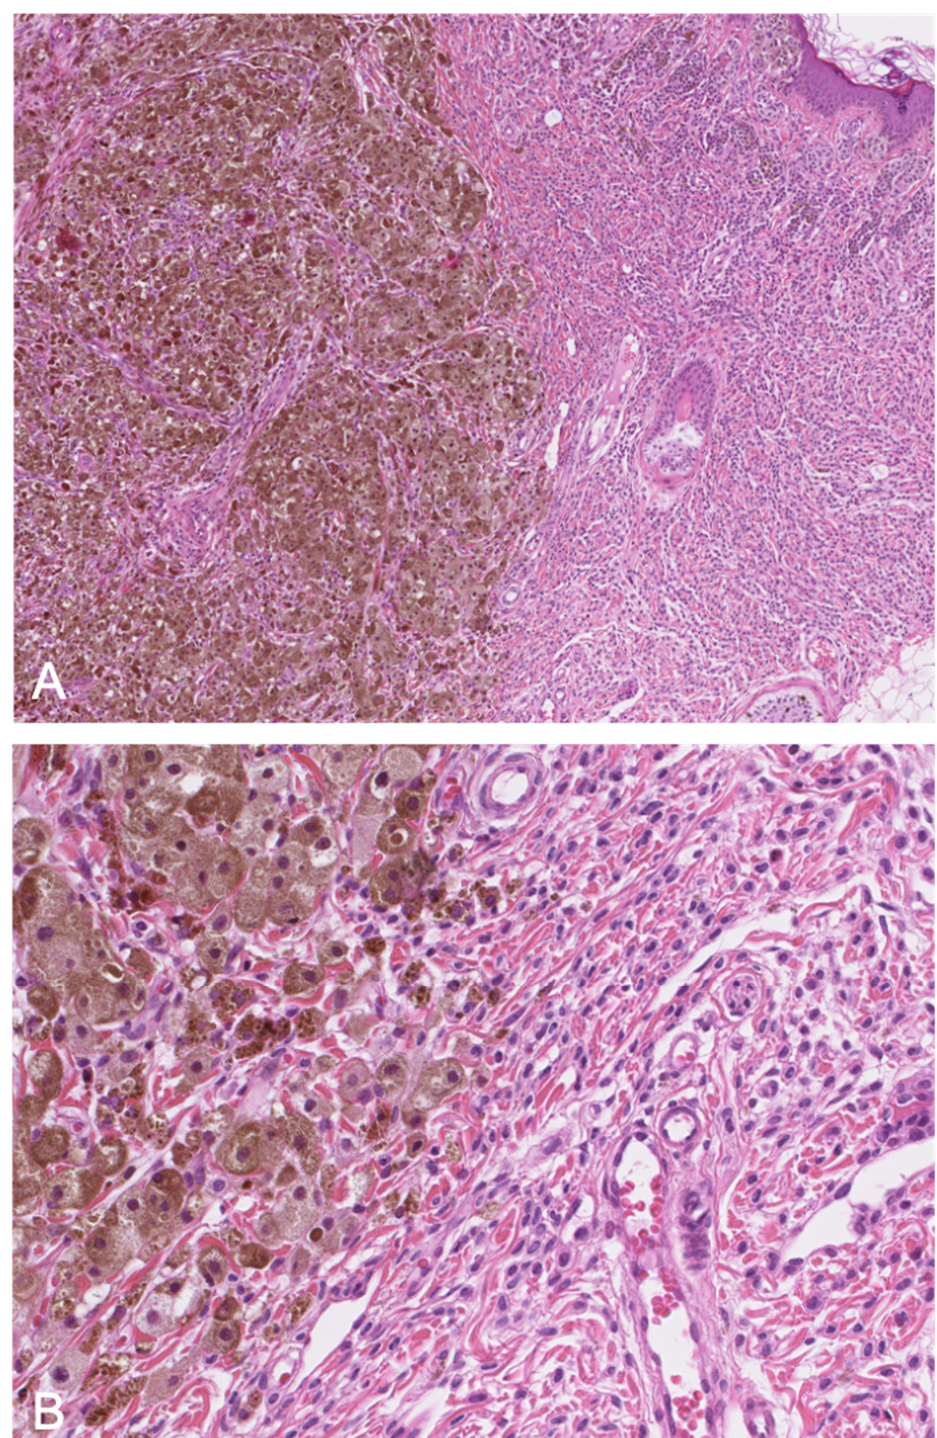
Figure 7. ( A ): (HE × 40) Proliferative nodule in a congenital melanocytic lesion. ( B ): (HE × 250) The melanocytes of the proliferative nodule are epithelioid and with a dusty cytoplasm, without nuclear atypia. Note the delicate transition (blending), which may be very focal and inconspicuous.